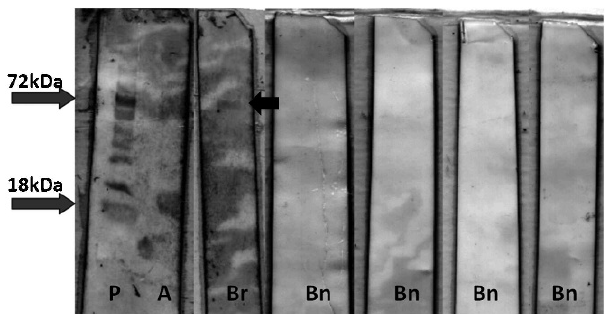
Figure 3 - Purified beta-lactoglobulin electroblotted on 0.45- m m pore-size nitrocellulose membranes after incubation with patient’s serum, primary antibody (goat IgG anti-human IgE), secondary antibody (HRP-conjugated rabbit anti-goat IgG) and DAB revelation. Immunoblot membranes exhibiting bands of s- IgE against b -lactoglobulin from four non-reactive patients in group B (Bn), from the single reactive patient from group B (Br), and from one reactive patient from group A (A) used as a control